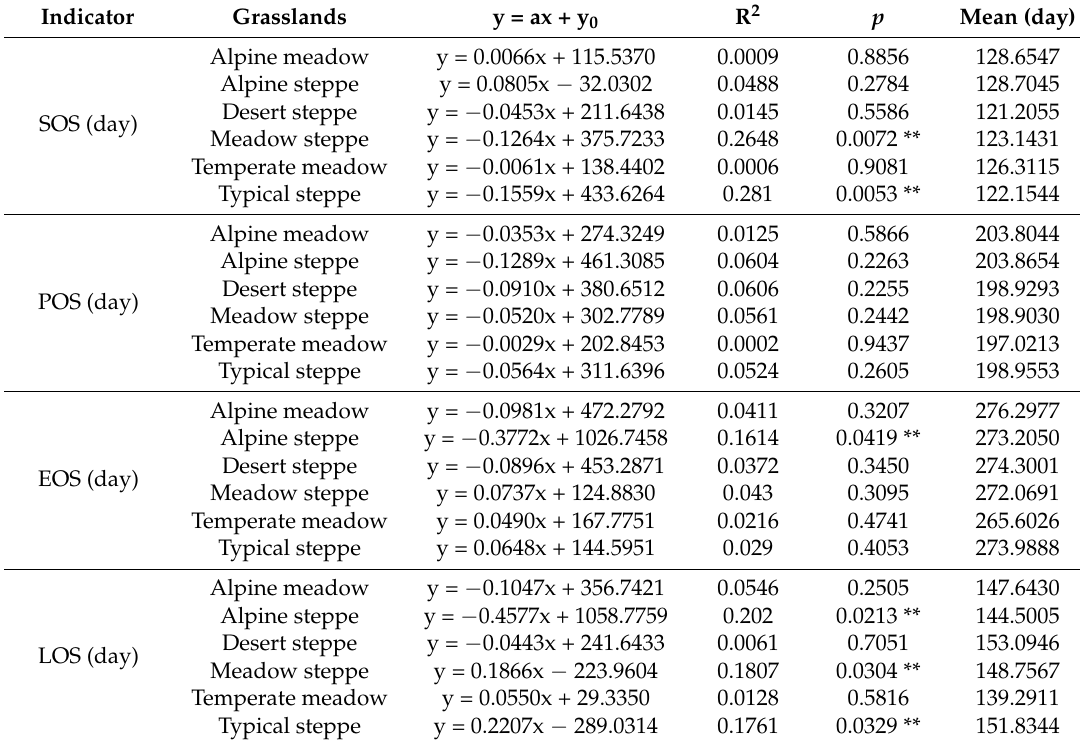
Table 1. The variation of vegetation phenology in different grasslands across northern China (1985–2010). y is the phenology indicator (start of the growing season [SOS], peak of the growing season [POS], end of the growing season [EOS], and length of the growing season [LOS]) ; x is the years 1985–2010; R2 is the fitting optimization index; p is the probability to reject the null hypothesis; y0 is the intercept; and a is the slope.